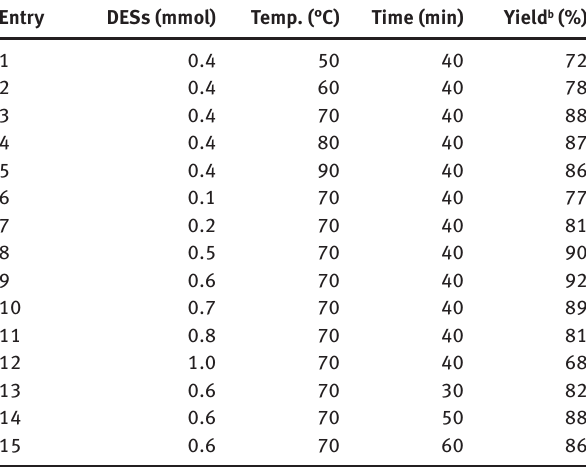
Table 2: Substrate scope for the Biginelli reaction in presence of ChCl/2PTAS.